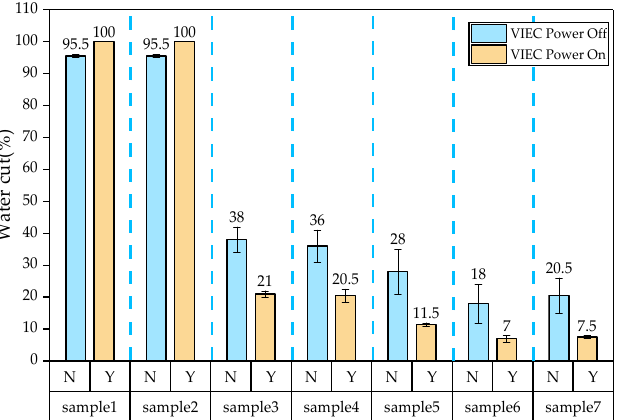
Figure 10. The average water cut of each sampling port in the VIEC power-on and power-off test under the large flow